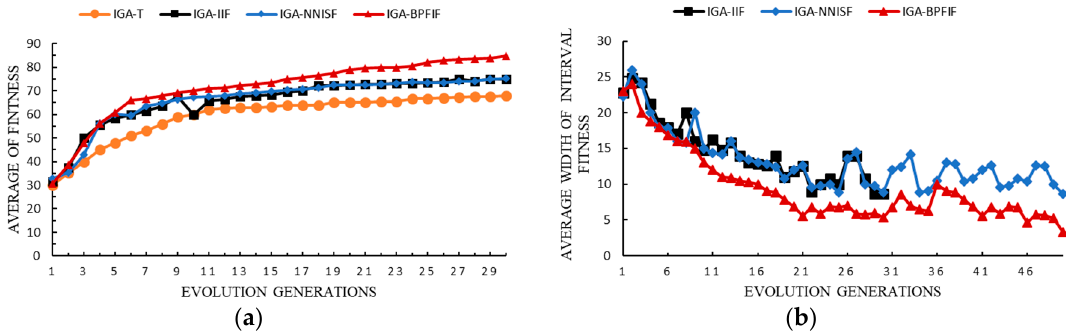
Figure 6. Comparison of the fitness of evolutionary individuals: ( a ) average of fitness and ( b ) average width of interval fitness.